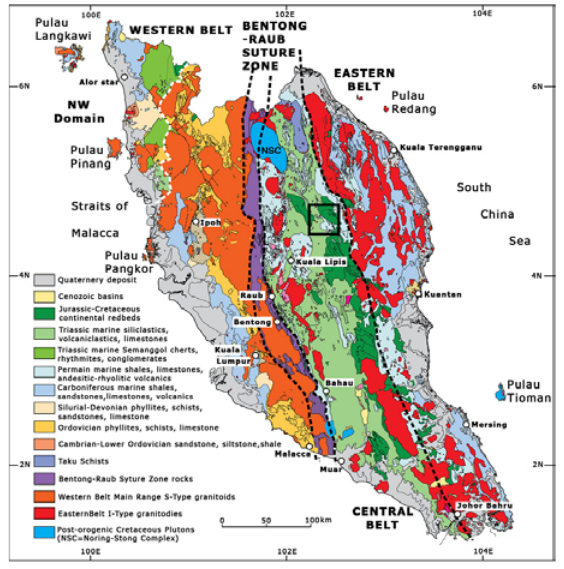
Figure 1. Simplified geological map of the peninsular Malaysia. Modified from Metcalfe, (2013). Study area is located in black